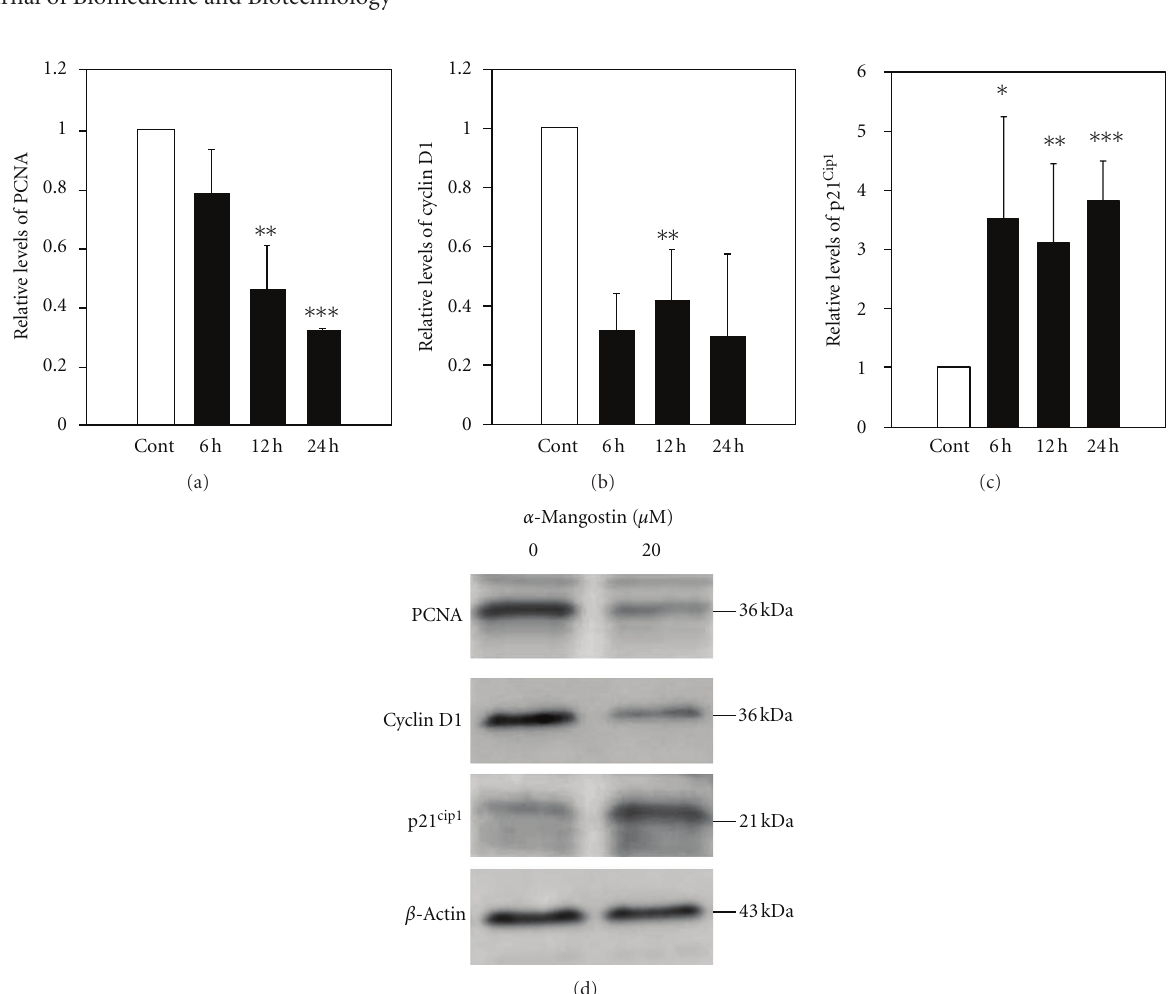
Figure 5: Changes in expression of genes involved in G1 phase regulation. (a)–(c) mRNA expressions of cell-cycle regulators for G1 phase, PCNA (a), cyclin D1 (b), and p21 cip1 (c), were examined using real-time PCR assays in MDA-MB231 cells after treatment with α -mangostin, as compared to controls. White bars indicate the results for controls and black bars indicate the results of analysis at 6 h, 12 h, and 24 h after treatment with α -mangostin ( ∗ P < 0 . 05, ∗∗ P < 0 . 01). PCNA and cyclin D1 expressions were significantly lower and p21 cip1 was significantly higher in cells treated with α -mangostin for 24h, as compared to controls. Relative target gene levels were calculated using the ΔΔ CT method. GAPDH was used as a reference gene. Data are presented as means ± SD of triplicate independent measurements. (d) Western blots of PCNA (36kDa) and cyclin D1 (36kDa) showed significantly lower levels, and p21 cip1 (21kDa) showed significantly higher levels in cells treated with α -mangostin for 24h, as compared to controls (left lane). These results were similar to those for PCR analysis, as shown in (a)–(c). β -Actin served as an internal control (lowest panel). Three samples from control and α -mangostin-treated cells were used for